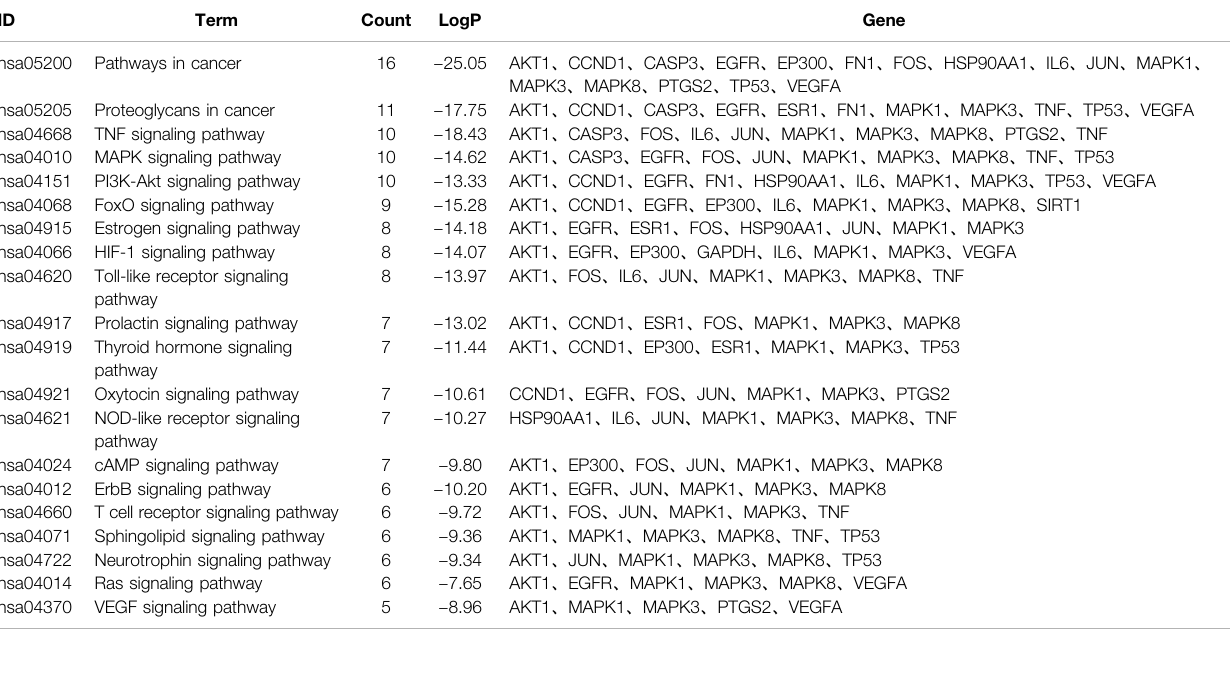
TABLE 3 | Top 20 clusters with their representative KEGG enrichment pathways.